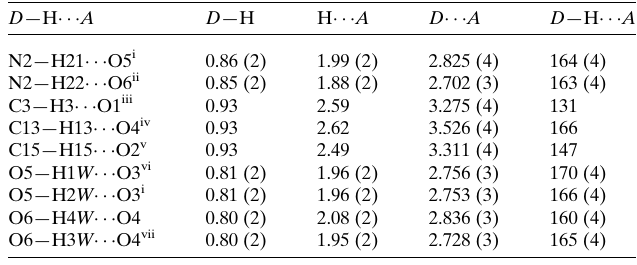
Table 1 Hydrogen-bond geometry (A˚ , (cid:5) ) for (I).